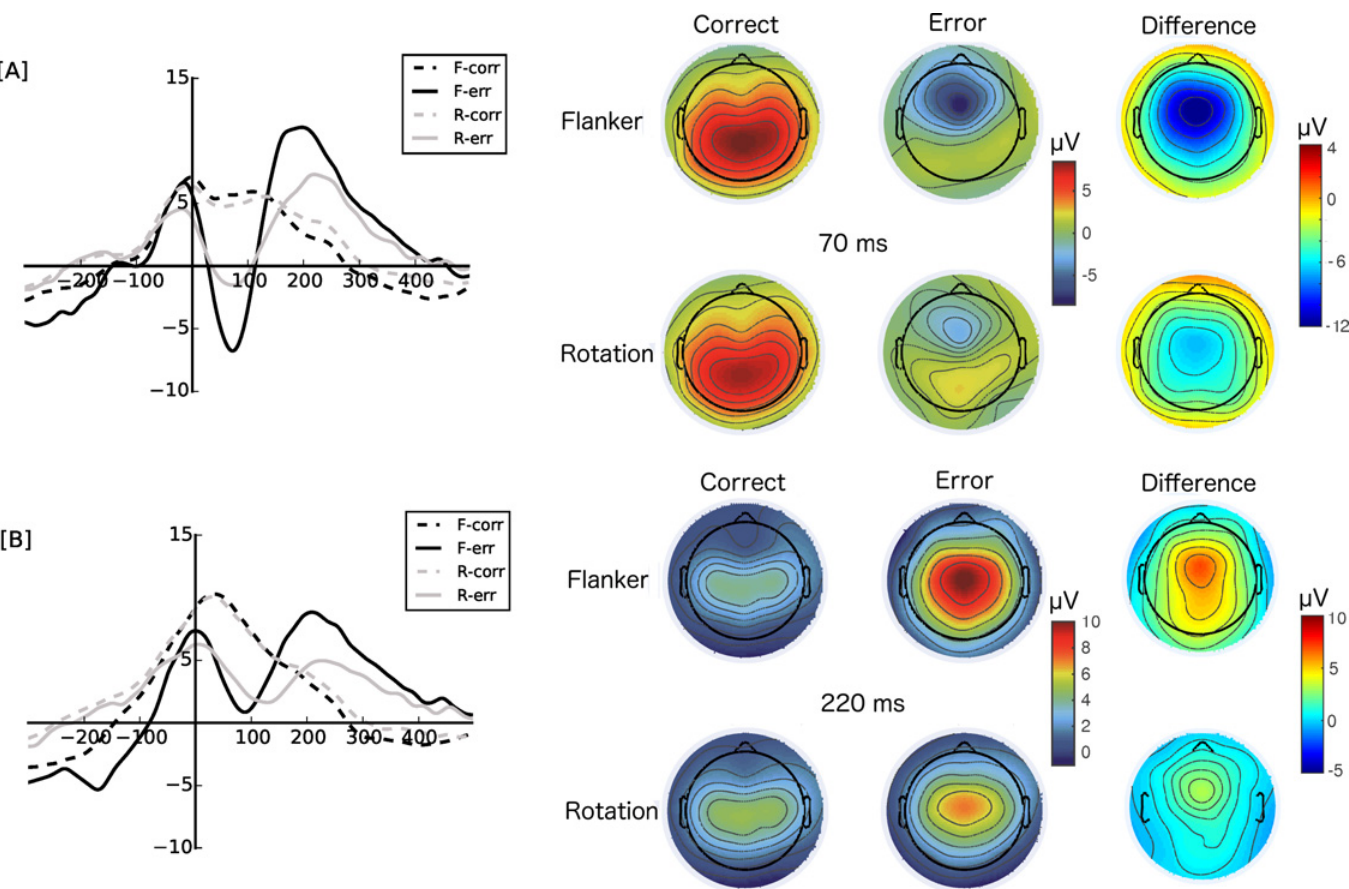
Fig 1. The left panel shows the error negativity at FCz [A] and the error positivity at Cz [B] for errors (-err) and correct (-corr) responses in the flanker task (F-) and rotation task (R-), respectively. The right panel shows the corresponding topographic maps (spherical spline interpolation) for the Ne (70 ms) and Pe peak (220 ms) as well as the difference topography (error-correct) for all conditions (flanker and rotation, correct and errors,